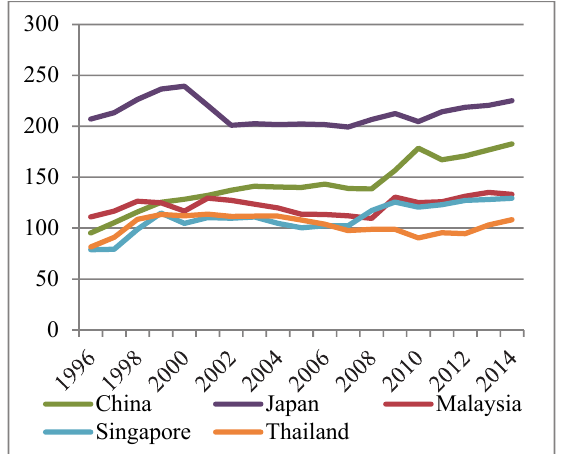
Fig. 3. Liquid liabilities in more developed finan- cial systems (% of GDP)